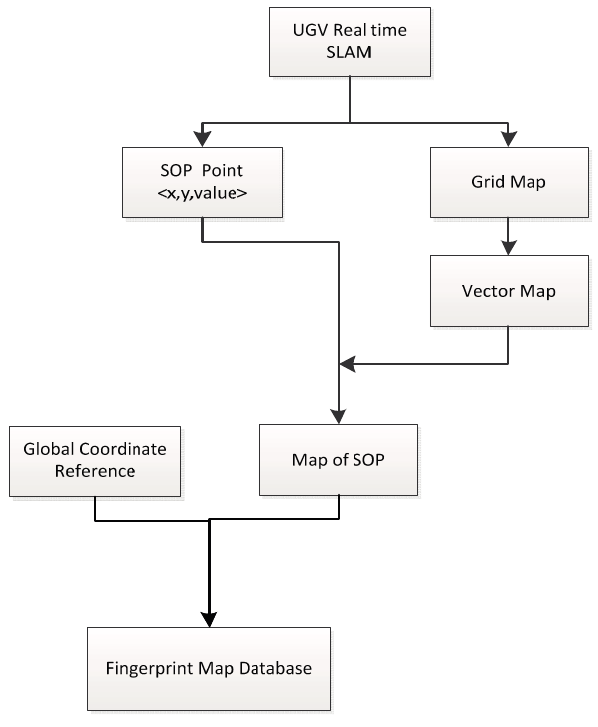
Figure 2. Workflow of SOP fingerprint database maintenance based on UGV